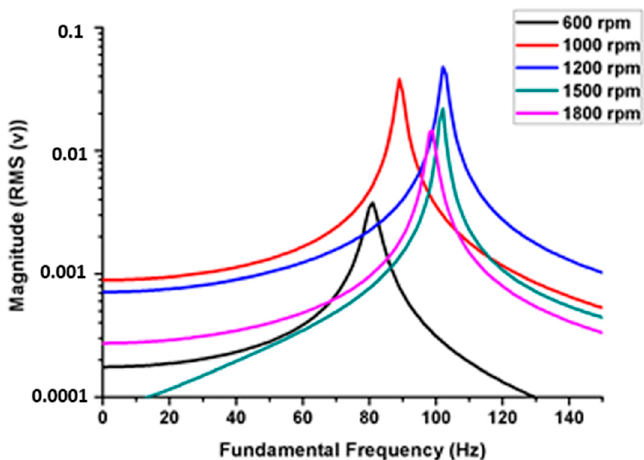
Figure 8. Frequency response function of different rotation speeds at a constant welding rate of 32 mm/min.